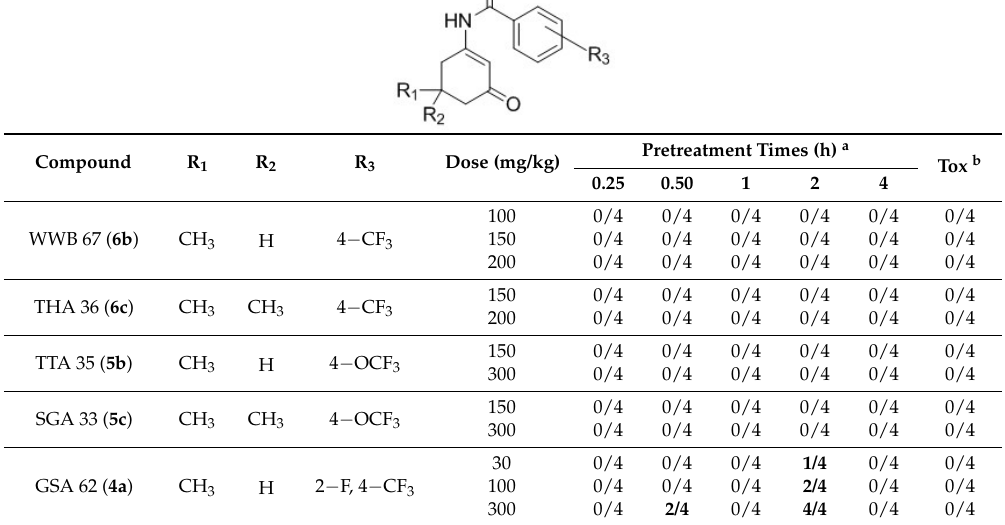
Table 2. Anticonvulsant activity: maximal electroshock (MES) test in mice. Compound